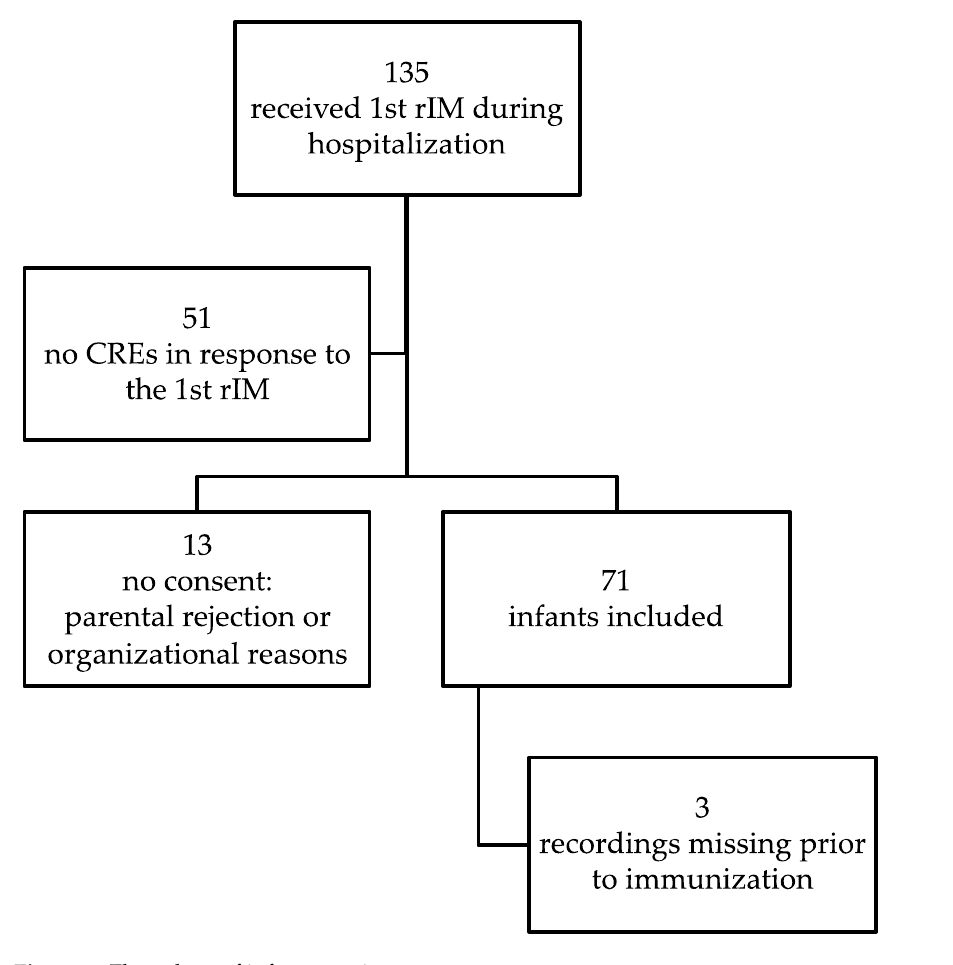
Figure 1. Flow chart of infant recruitment. Table 1. Clinical data of included infants.